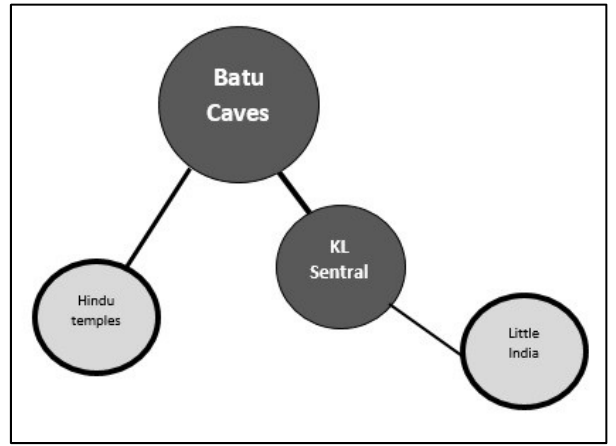
Figure 11. A POI graph with route context [45].